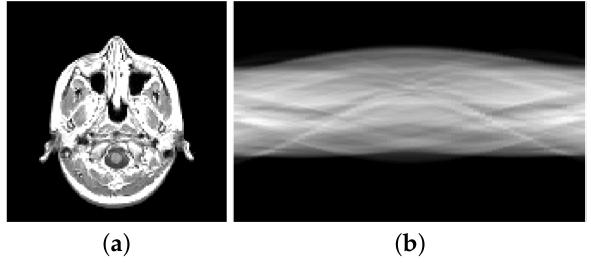
Figure 15. Slice of a human head and its measured sinogram. ( a ) Original image; ( b ) Sinogram.